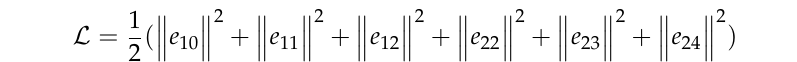
Figure 7. Joint calibration graph optimization